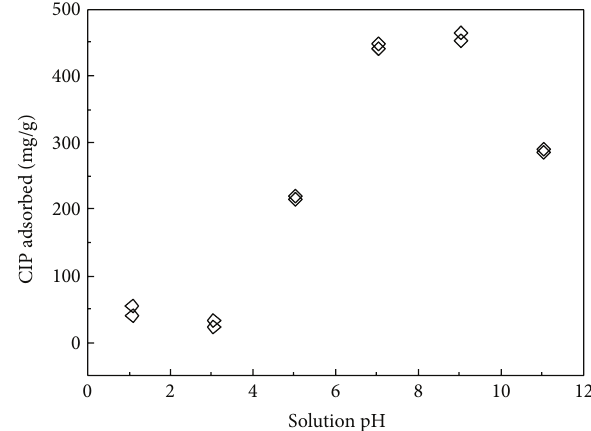
Figure 3: Adsorption of CIP on birnessite (V) affected by solution